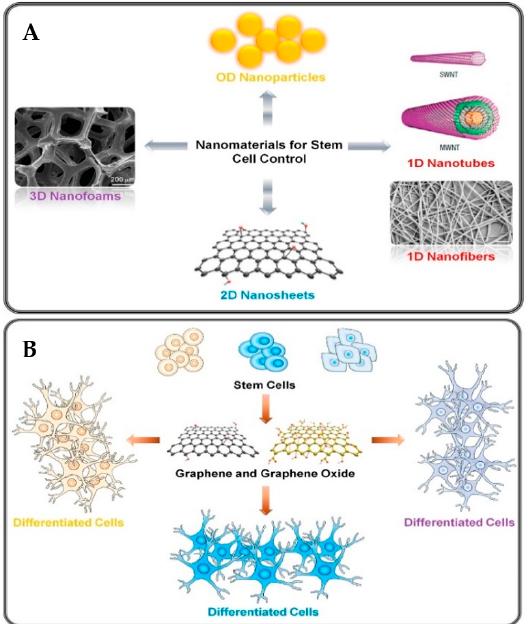
Figure 2. Selective nanomaterials and stem cell growth. ( A ) Potential carbon allotropes for stem cell differentiation and growth, ( B ) the effect of graphene and GO on stem cell growth, proliferation, and tissue lineages [10].